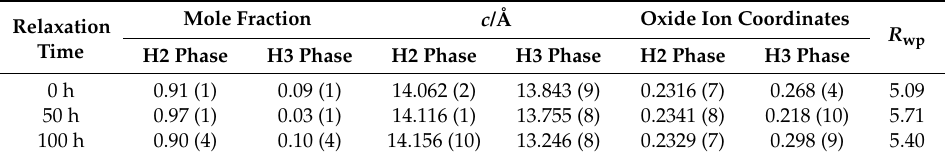
Figure 4. Obtained mole fraction change of Li 0.12 Ni 0.874 Co 0.090 Al 0.036 O 2 during the relaxation time. Closed and open symbols correspond to the H2 and H3 phase, respectively. Table 1. Refined structure parameters of Li 0.12 Ni 0.874 Co 0.090 Al 0.036 O 2 for initial state, and after 50 and 100 h of relaxation.